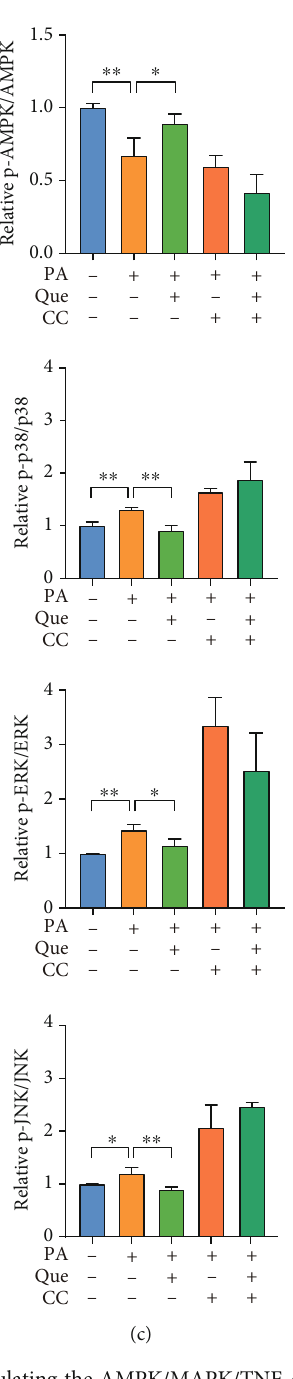
Figure 8: Quercetin suppresses in fl ammation by regulating the AMPK/MAPK/TNF- α signaling pathway in PA-induced HepG2 cells. (a) qPCR analyses of TNF- α mRNA levels in HepG2 cells stimulated by 0.4mM PA with DMSO or 25 μ M quercetin for 24h ( n = 7 − 8 ). (b) Western blot analysis of p-AMPK, AMPK, p-p38, p38, p-ERK, ERK, p-JNK, and JNK levels in HepG2 cells stimulated by PA with quercetin ( n = 3 ). (c) Gray value analysis of p-AMPK/AMPK, p-p38/p38, p-ERK/ERK, and p-JNK/JNK. Data are presented as the